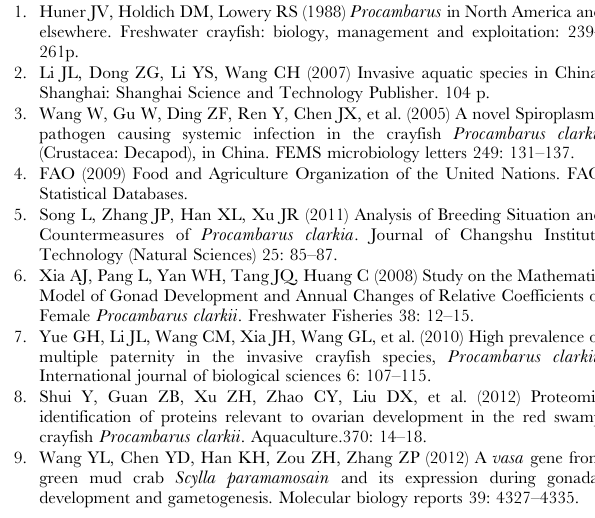
(TIF) Figure S2 Neighbor-joining phylogenetic analysis of the vasa from P. clarkii . (TIF) Figure S3 Localization of cyclin B and titin transcripts in crawfish gonads. The results of In situ hybridization with DIG-labeled antisense RNA probe (B and D for cyclin B ; G and I for titin ) and sense probe as negative control (C and E for cyclin B ; H and J for titin ) were shown. Regular histological section was stained with hematoxylin and eosin (A and F). O: oogonium; Cy: cytoplasm; N: nucleus; Nu, nucleolus; Fc: follicle cells; Sg: spermatogonium; Sc: Spermatocyte; St: Spermatid; The scale bar indicates 100 m m. (TIF) Table S1 Real-time PCR confirmation of differential expressed genes. Table S2 KEGG biochemical pathways of P. clarkii isotig sequences. Table S3 List of the up-regulated and down-regulated genes between male and female